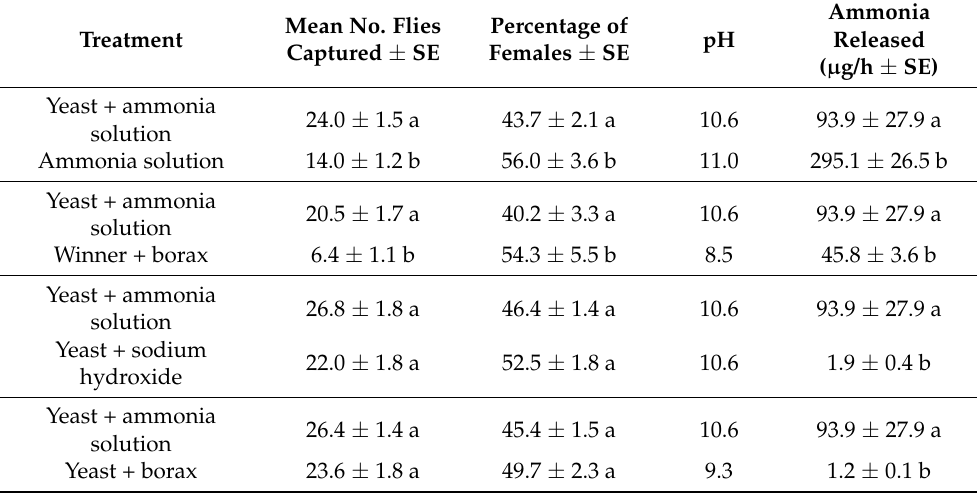
Table 2. Paired comparisons of mean ( ± SE) captures of A. obliqua flies, percentage of females captured, and quantities of ammonia released from individual traps baited with the 150 mM ammonia solution alone or in mixtures with 1% torula yeast, Winner + borax, or torula yeast alkalized by the addition of sodium hydroxide or borax. Mean No. Flies Percentage of Treatment Captured ± SE Females ± SE